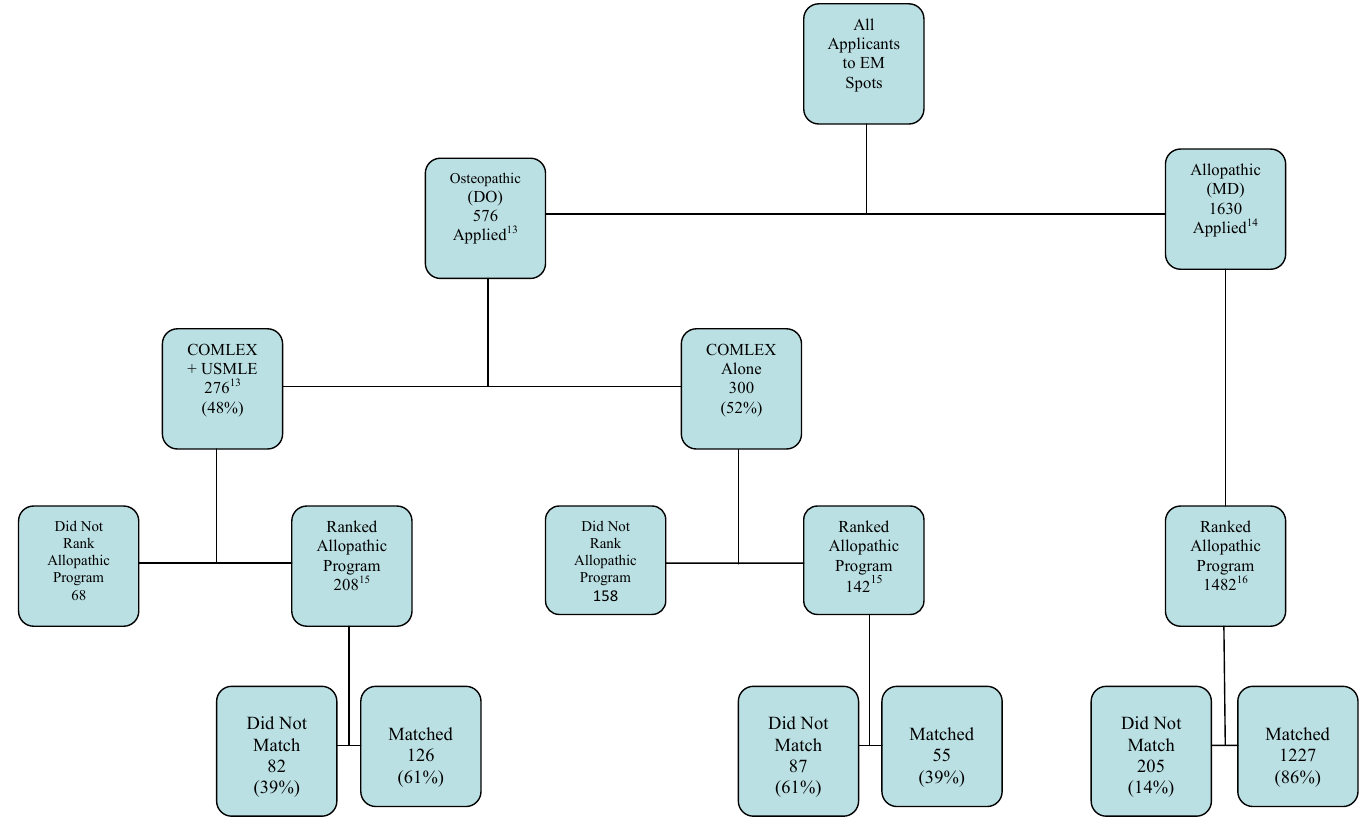
Figure 2. Flow of